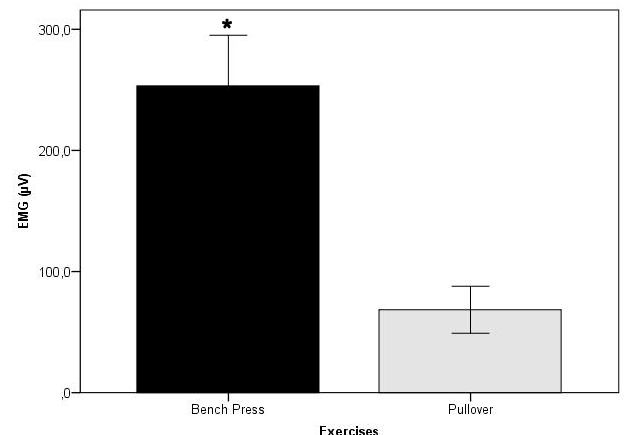
Figure 4. Comparison of electromyographic activation of anterior deltoid between horizontal bench press and Barbell Pullover exercises (Mean and SD). # p < 0.05 - significant